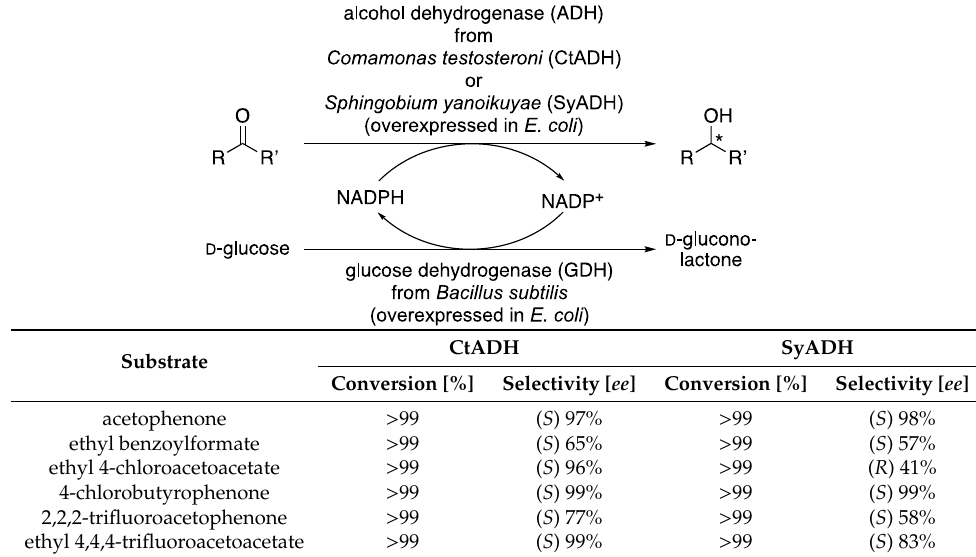
Table 3. Reduction of selected ketones by CtADH and SyADH. Degrees of conversion and ee values were determined by chiral GC. (* marks the chiral center of the product.)